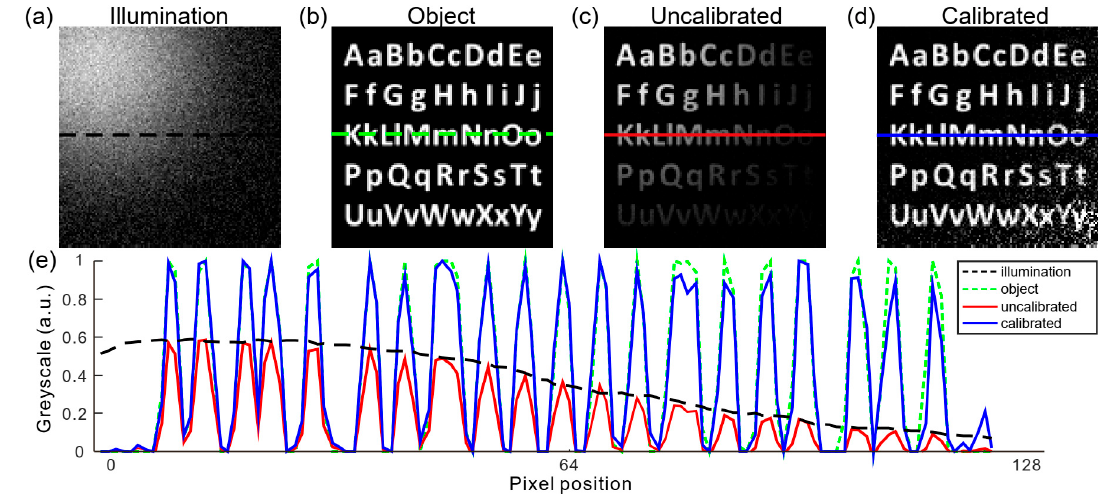
Figure 2. Numerical simulation. ( a ) Non-uniform illumination. ( b ) Object. ( c ) Uncalibrated reconstructed image; its root mean square error (RMSE) is 0.2548. ( d ) Calibrated reconstructed image; its RMSE is 0.0999. ( e ) Intensity distributions comparison.